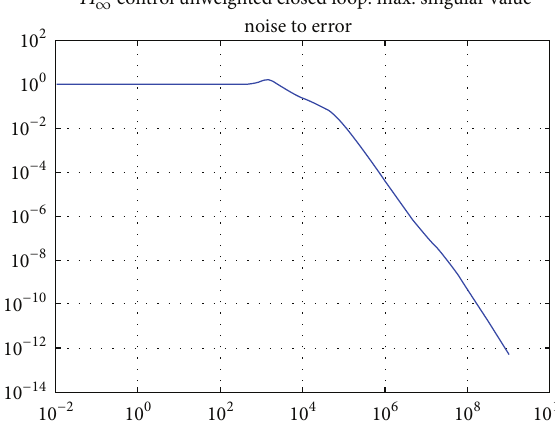
Figure 13: Maximum singular value noise to error.